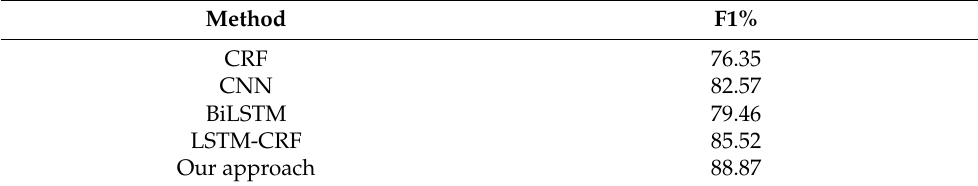
Table 5. Comparison of experimental results of multiple models.